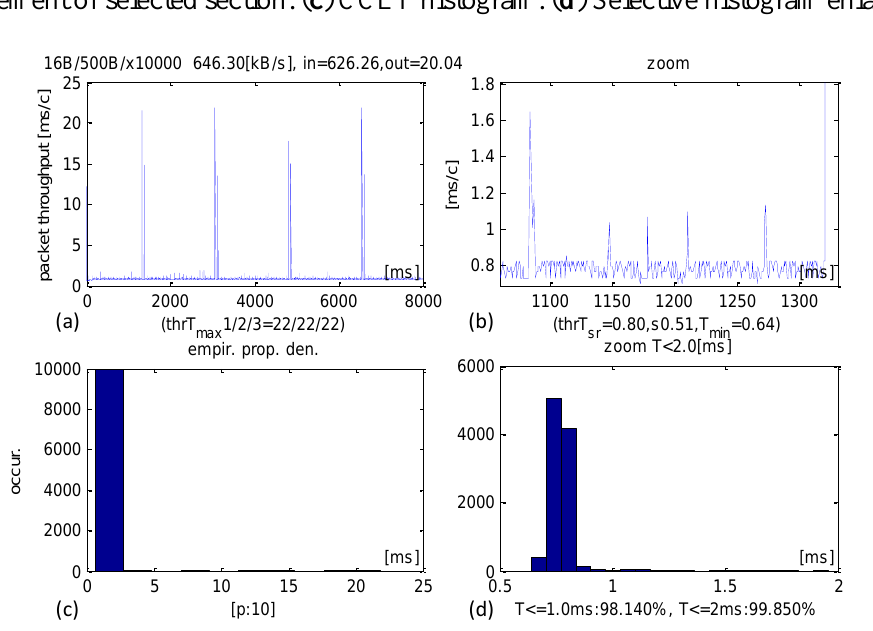
Figure 6. Experimental results of CCLT for packets IN = 500 B. ( a ) Recorded CCLTs.